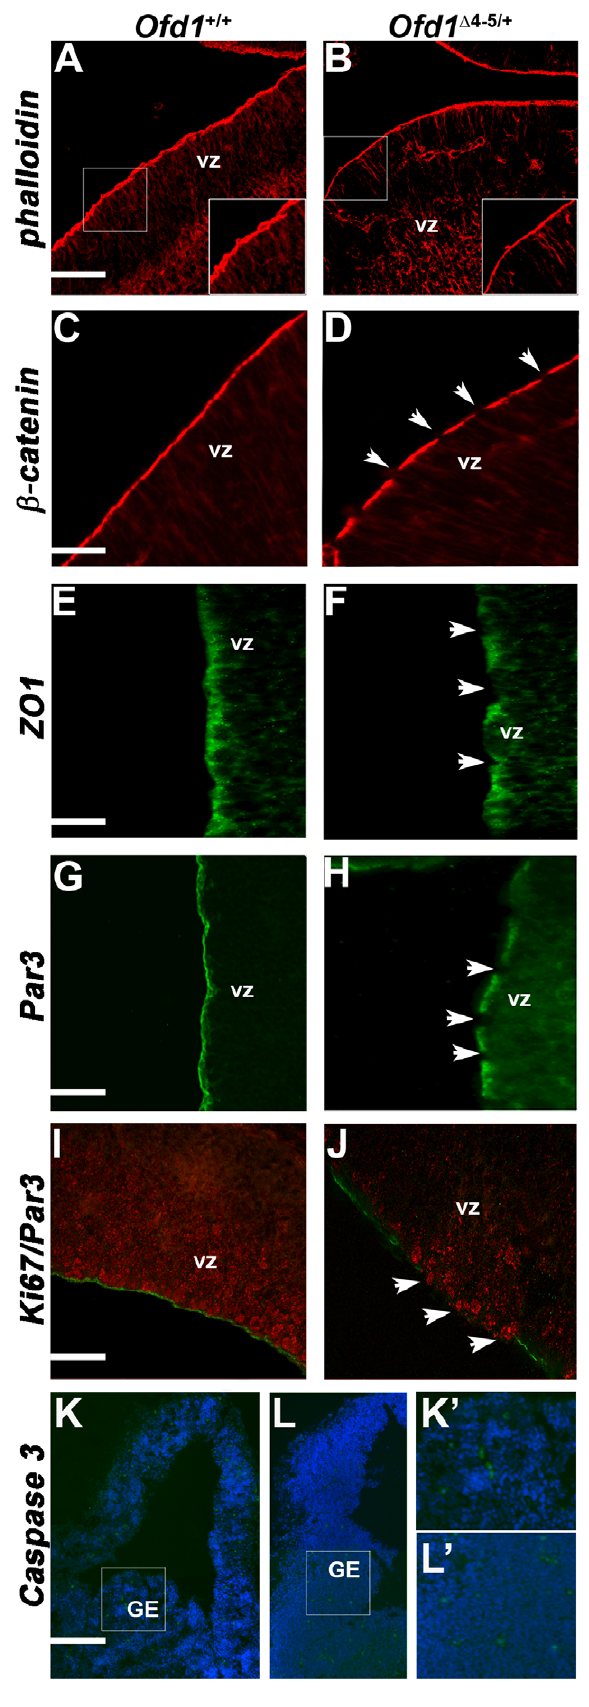
Figure 7. Cytoskeletal organization and cell polarity are altered in Ofd1 D 4–5/ + embryos. Staining for F-actin with fluorescent phalloidin reveals a reduced signal and actin disorganization at the cell apex in severely affected Ofd1 D 4–5/ + mutants (B) with respect to wild-type Ofd1 + / + embryos (A). Scale bars: 200 m m. A higher magnification of the actin boundary indicates a reduced thickness in mutant embryos (inset B) compared to wild-type Ofd1 + / + embryos (inset A). Immunofluores- cence with b -catenin reveals a continuous band in wild-type embryos (C) but a punctuate and discontinuous band in Ofd1 D 4–5/ + severe mutants (D). Scale bars: 100 m m. Immunofluorescence analysis of ZO1, a marker of tight junctions, shows a discontinuous pattern along the margin of the ventricular surface (F) compared to wild-type embryos (E). Scale bars: 50 m m. Immunostaining of Par3 with a discontinuous pattern along the cells lining the ventricular zone in Ofd1 D 4–5/ + severe mutant embryos (H) compared to wild-type embryos (G). Scale bars: 50 m m. White arrows in panels D, F, H indicate expression discontinuity along the apical membrane. Immunostaining of Ki67 (in red) and Par3 (in green) indicate reduced Ki67 expression and presence of abnormally located cortical progenitors, which tend to protrude outside the ventricular zone in Ofd1 D 4–5/ + severe mutant embryos (J) compared to wild-type embryos (I). Scale bars: 200 m m. vz: ventricular zone. Immunofluorescence analysis of Caspase 3 revealed no difference in the number of apoptotic cells in wild-type embryos (K) and in Ofd1 D 4–5/ + severe mutant embryos (L). Dashed rectangles designate enlarged areas indicated in panels K 9 and L 9 showing apoptotic cells in the ganglionic eminence (GE) region. Scale bars: 500 m m.